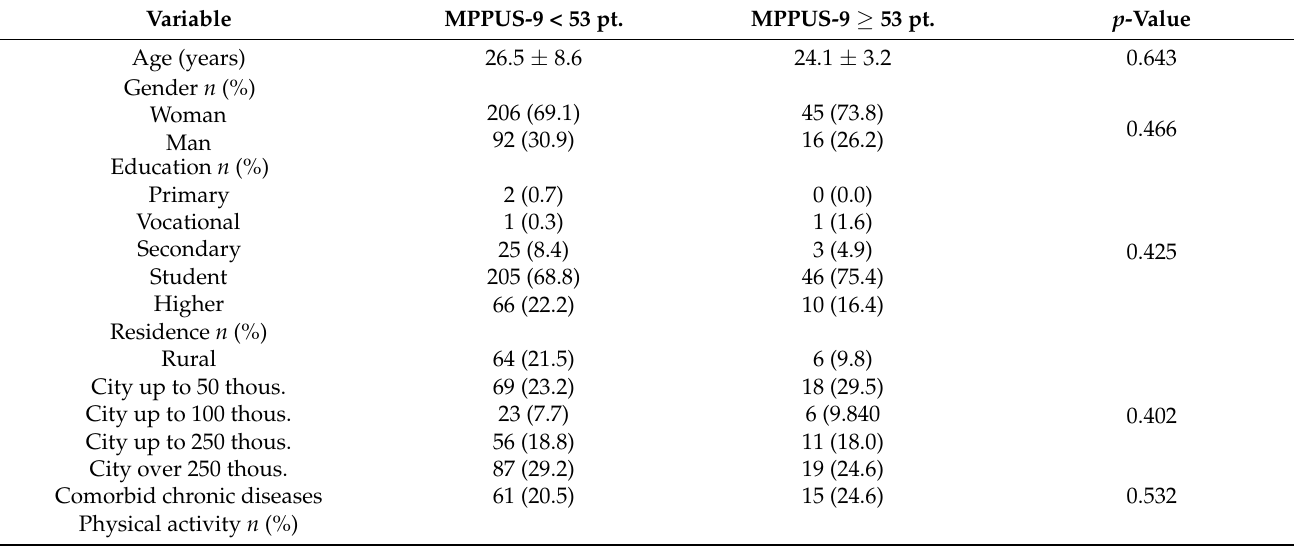
Group comparison between individuals that meet the criteria for phonoholism (MPPUS-9 ≥ 53) and a group of participants that does not meet the criteria for phonoholism (MPPUS-9 < 53), regarding demographics. Mann–Whitney U test was performed for quantitative variables and Fisher’s exact test was performed for qualitative